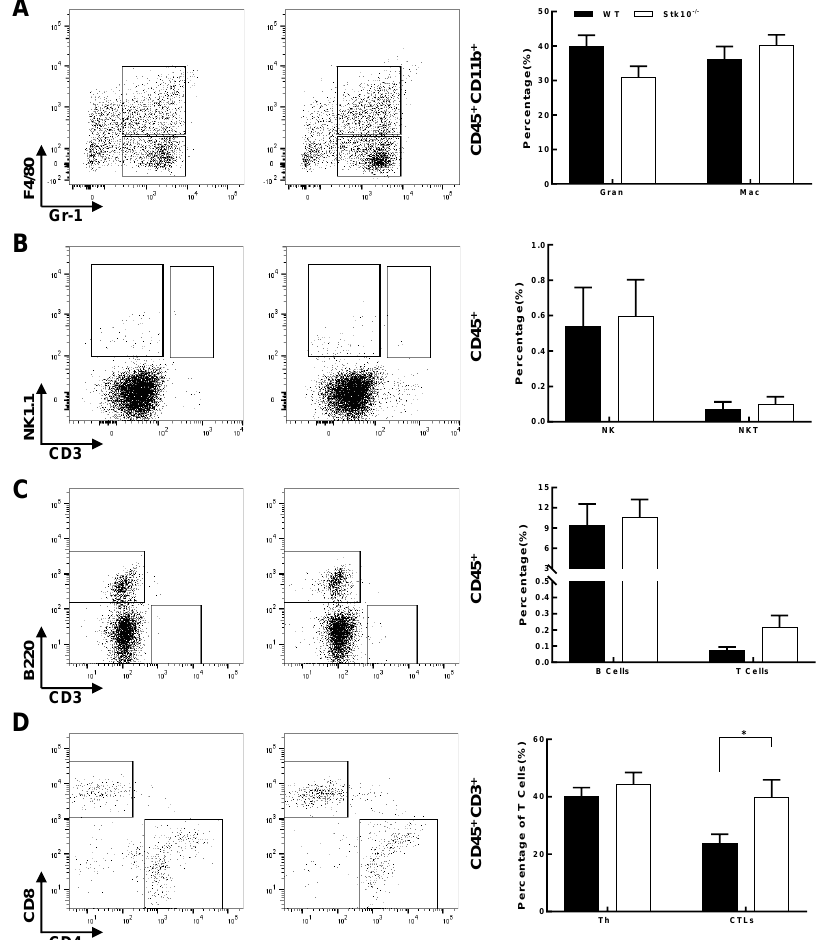
Figure 5. Flow cytometry analysis of tumor-infiltrating immune cells in tumors in WT and Stk10 knockout mice. ( A ) Neutrophile granulocytes (CD45 + CD11b + Gr-1 + ) and macrophages (CD45 + CD11b + F4/80 + ). ( B ) NK cells (CD45 + NK1.1 + ) and NKT cells (CD45 + NK1.1 + CD3 + ). ( C ) B cells (CD45 + B220 + ) and T lymphocytes (CD45 + CD3 + ). ( D ) Th cells (CD45 + CD3 + CD4 + ) and CTLs (CD45 + CD3 + CD8 + ). Representative results from three independent experiments are shown. Data represent the mean ± SEM. Statistical significance was determined by two-sided unpaired Student’s t -test. * p < 0.05. n = 5/group.